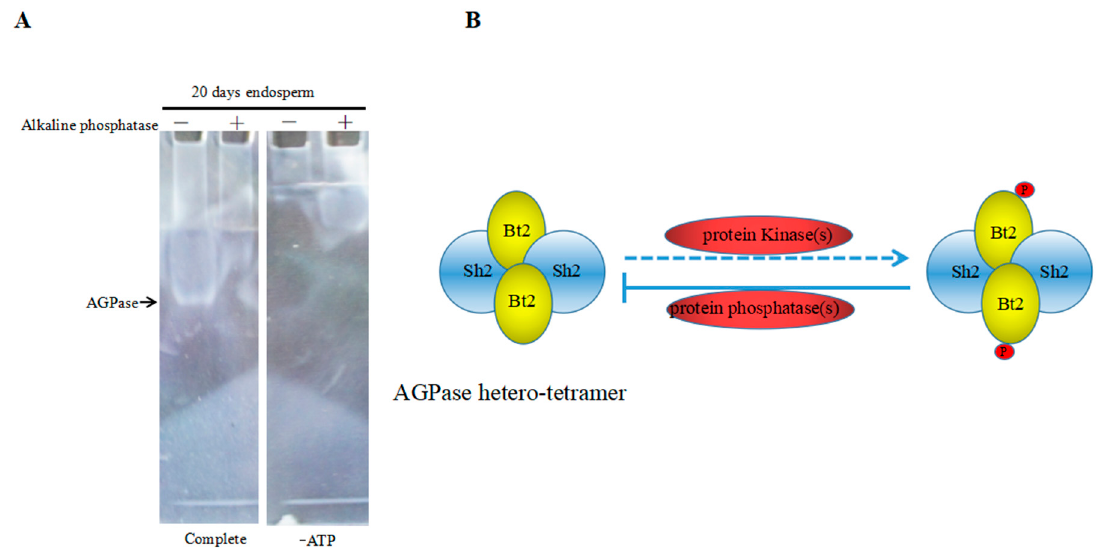
Figure 7. Enzyme characteristics of AGPase dephosphorylation and a potential regulatory model. ( A ) Native gel was performed with 40 µ g total maize endosperm protein and protein treated with alkaline phosphatase at 20 days after pollination. Gel was incubated in reaction buffer including ATP and Glc-1-P(Complete) in the presence of divolent cations or in the same buffer lacking ATP (-ATP). Arrow show that the white band is native AGPase band. ( B ) Putative potential regulatory model of phosphorylation of AGPase. Sh2: large subunits.